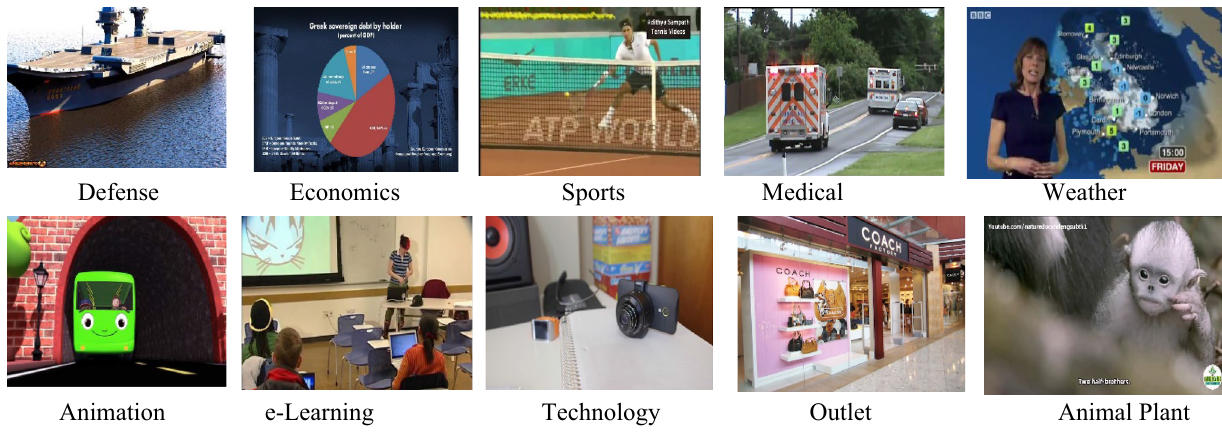
Fig. 7 Examples of successful classification of the proposed approach on STD dataset. Original Source: [8]